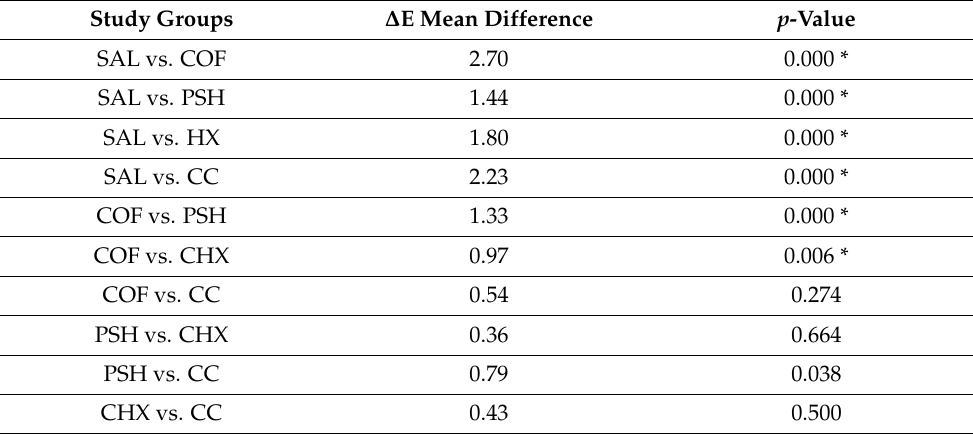
Figure 2. Mean and SD of ∆L, ∆a, and ∆b values among study groups. Table 3. Statistical comparison of ∆ E values among study groups (Tukey’s post hoc